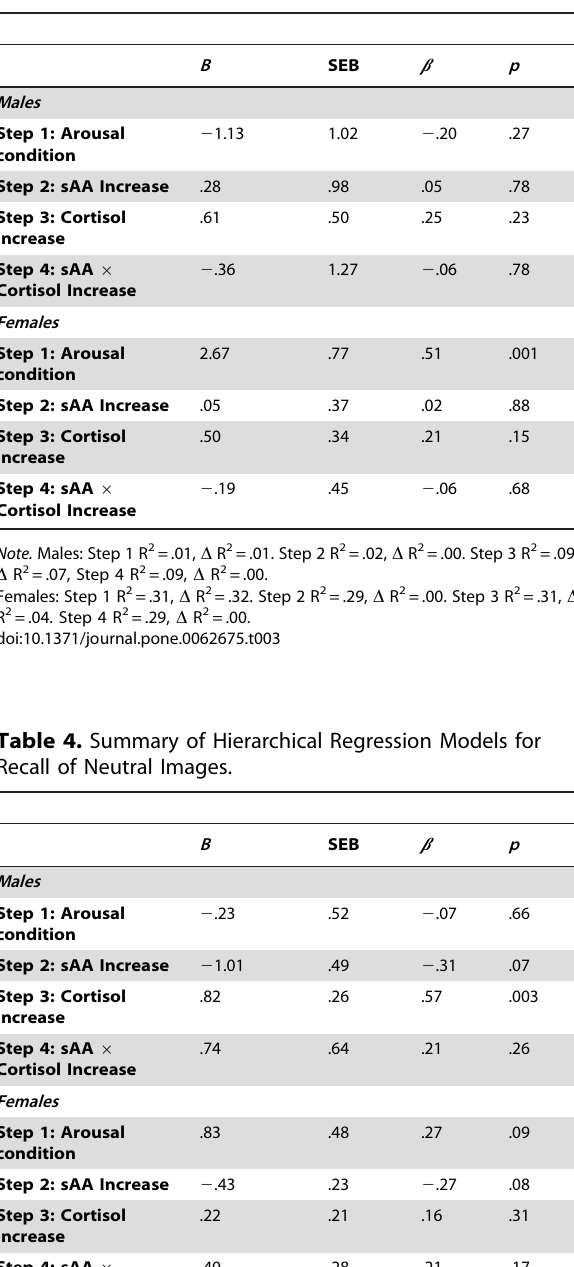
Table 2. Free Recall and Intrusive Memory Responses. Table 3. Summary of Hierarchical Regression Models for Recall of Negative Images.